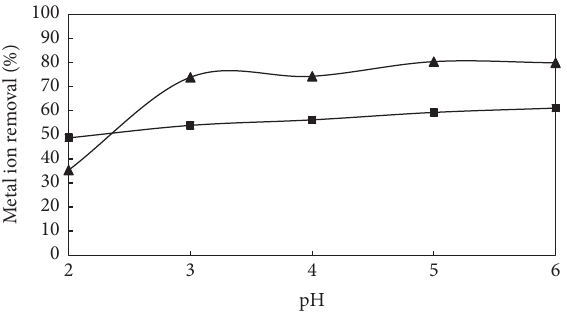
Figure 7: Percentage of Ni 2+ ( ◼ ) and Zn 2+ ( 󳵳 ) ions removal with varying pH in binary metal sorption.